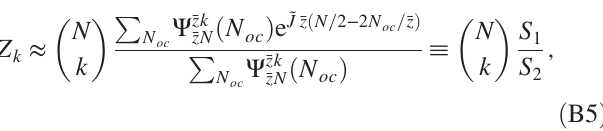
FIG. 11. Relative error of the approximate free energy density ˜ h ¼ 0 obtained by (a) the Bethe-Guggenheim and (b) the for ˜ μ ¼ mean field approximation as a function of the system size. Up to N ¼ 36 , each point corresponds to the relative error for a square ffiffiffiffi ffiffiffiffi p p N N lattice of size × with free boundary conditions and φ ¼ 1 = 2 closed bonds. For N ¼ 42 , a rectangular lattice of size 6 × 7 with free boundary conditions is